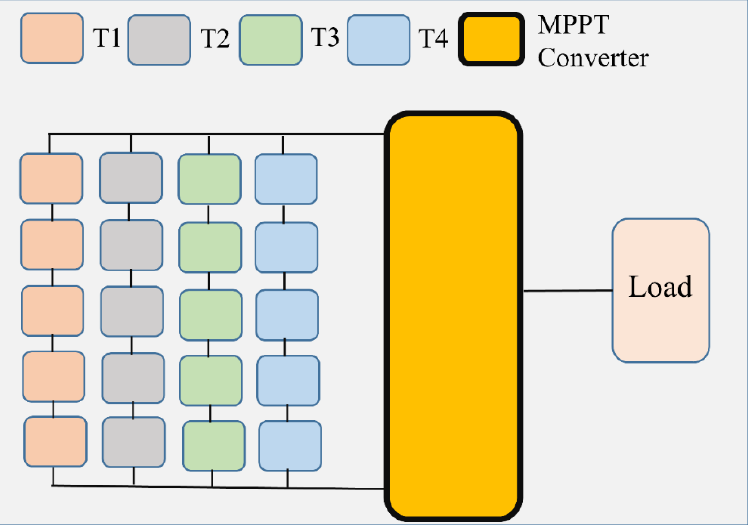
Figure 4. Centralized TEG system